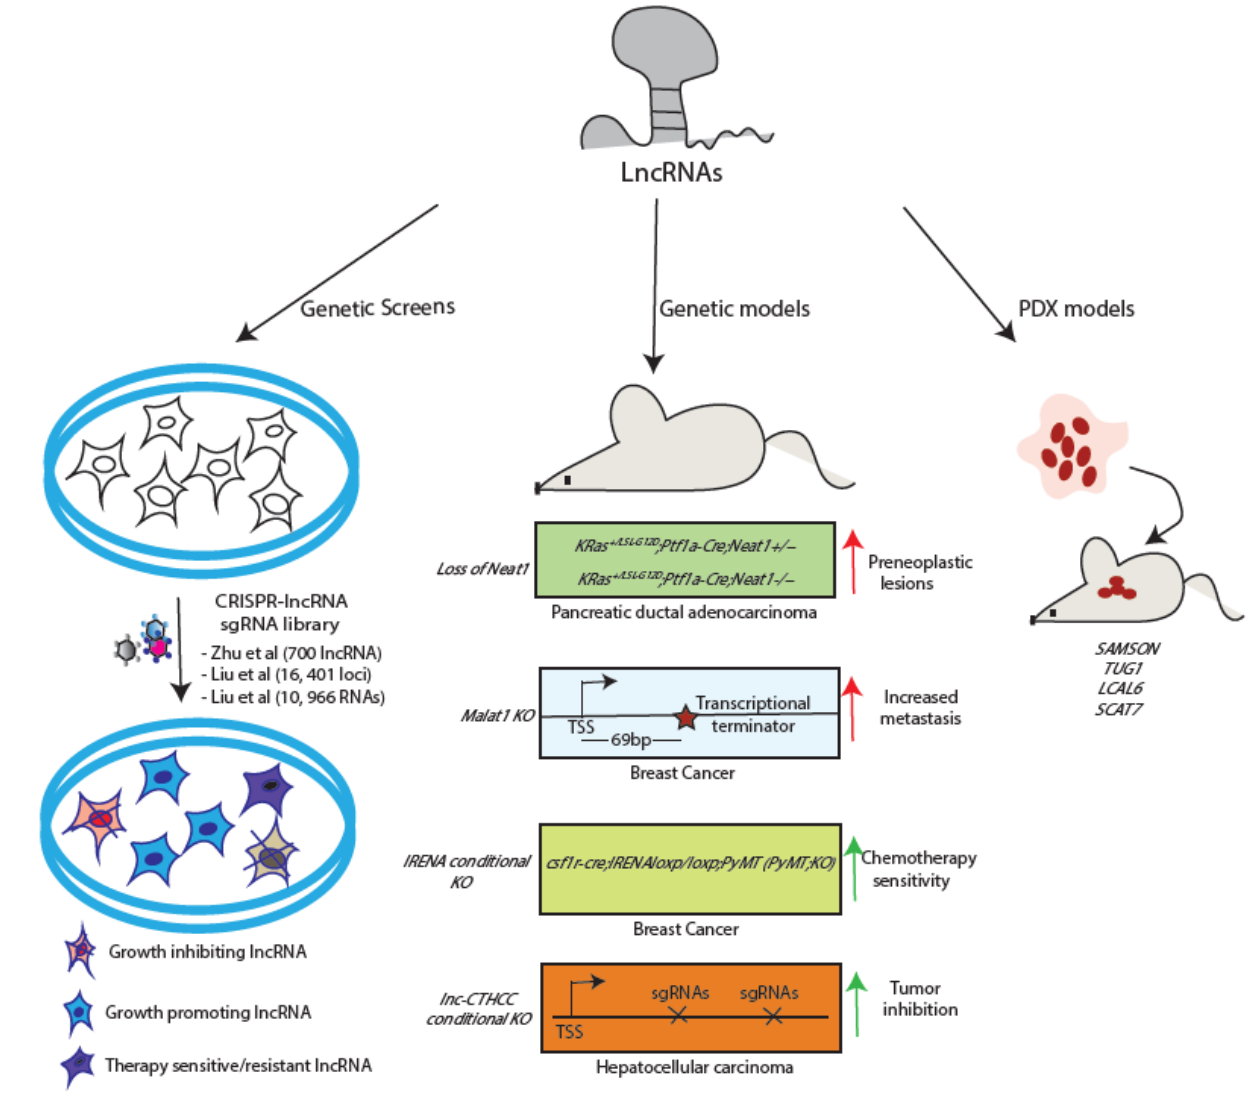
Figure 2. Available approaches for functional characterization of lncRNA. Genetic screens can be used for identification of functional lncRNAs. Individual candidates can be studied using mouse models or PDX models.